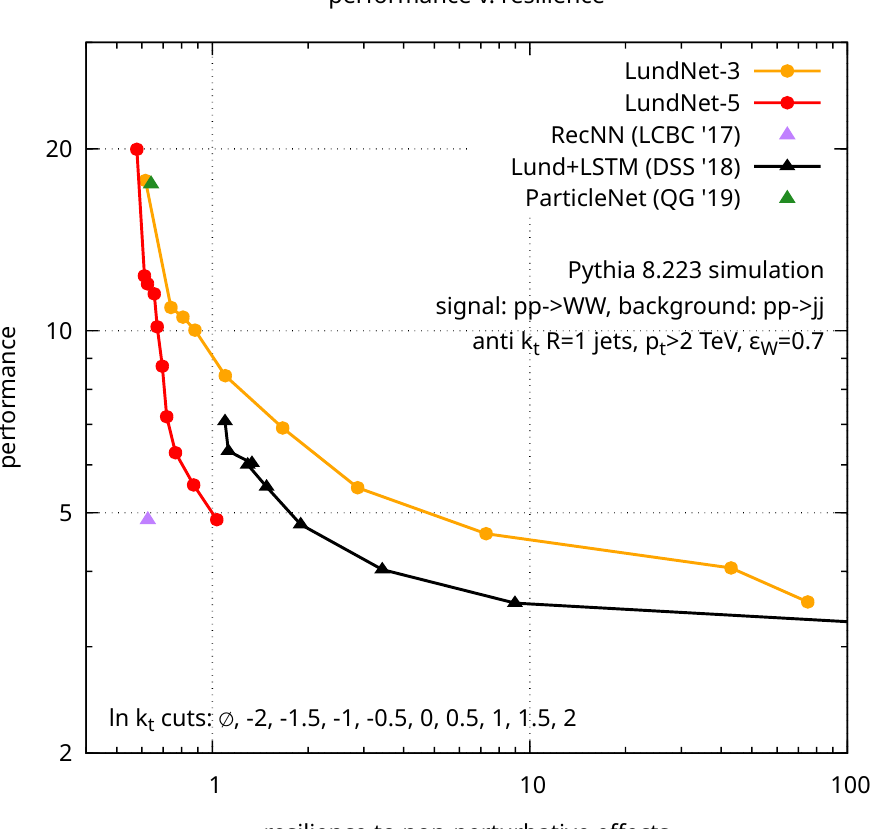
versus resilience to non-perturbative (cid:15) QCD